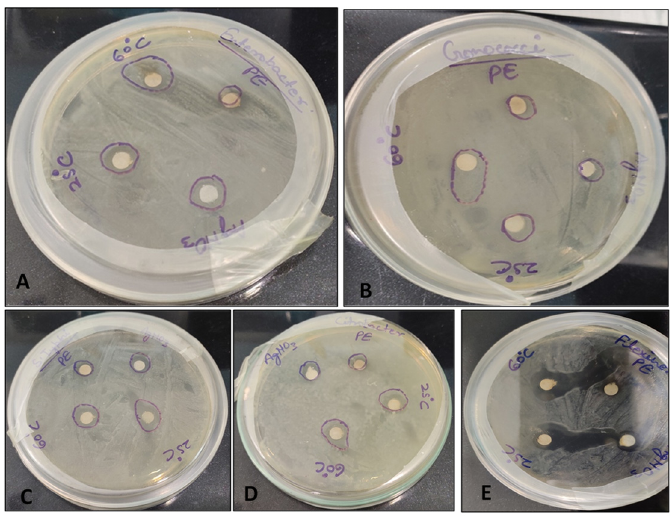
Figure 4. Zone of inhibition of silver nanoparticles against human pathogenic bacteria. ( A ) Entero- bacter faecalis, ( B ) Gonococci spp., ( C ) Salmonella Typhi, ( D ) Citrobacter spp., ( E ) Shigella flexineri